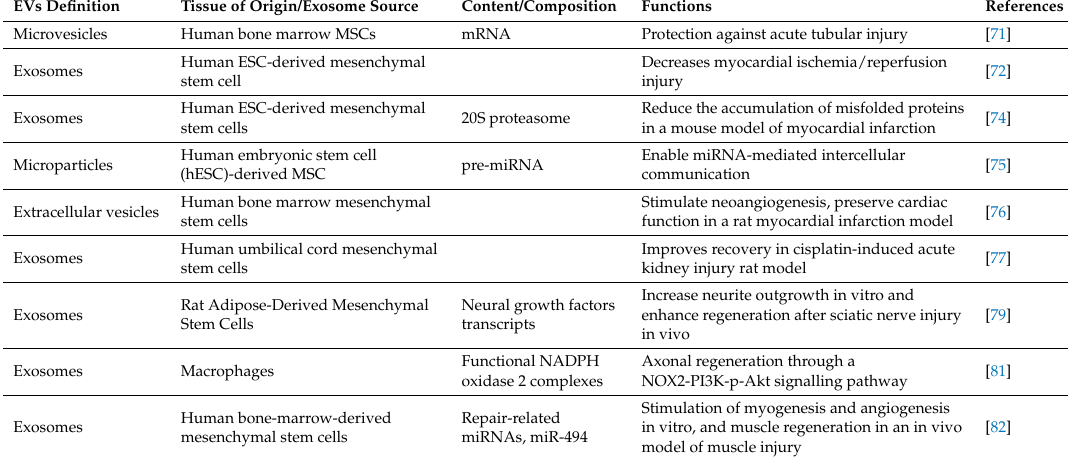
Table 1. Mesenchymal stem cells (MSC)-derived extracellular vesicles